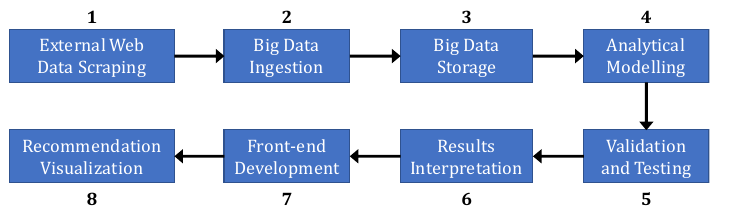
Figure 3. Detailed stages in proposed TRS model.